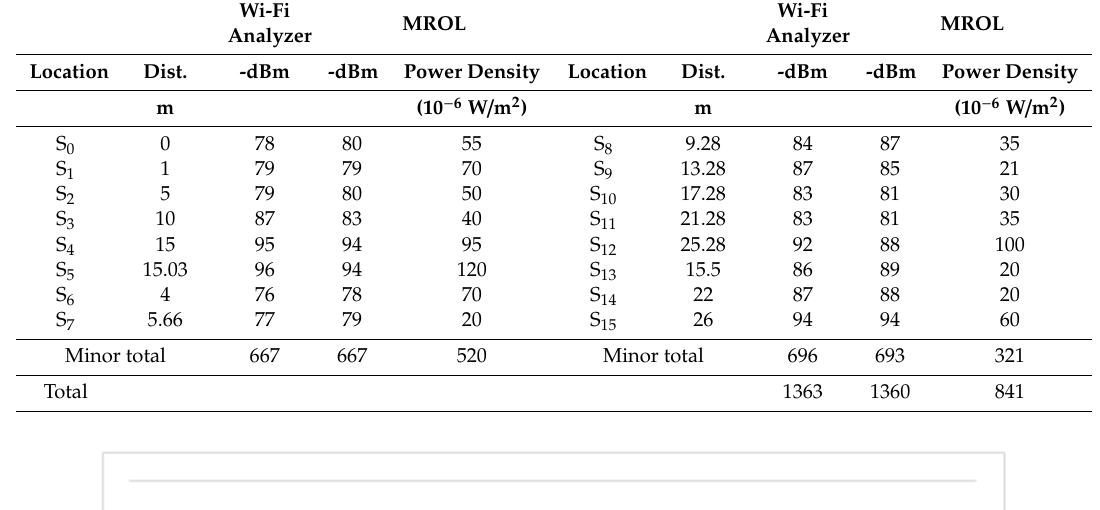
Table 1. Original data of signal strength and total electromagnetic wave power density for S 0 , S 1 , ... , and S 15 . Note: MROL, multiple-route optimization layout. Wi-Fi MROL Analyzer Location Dist.